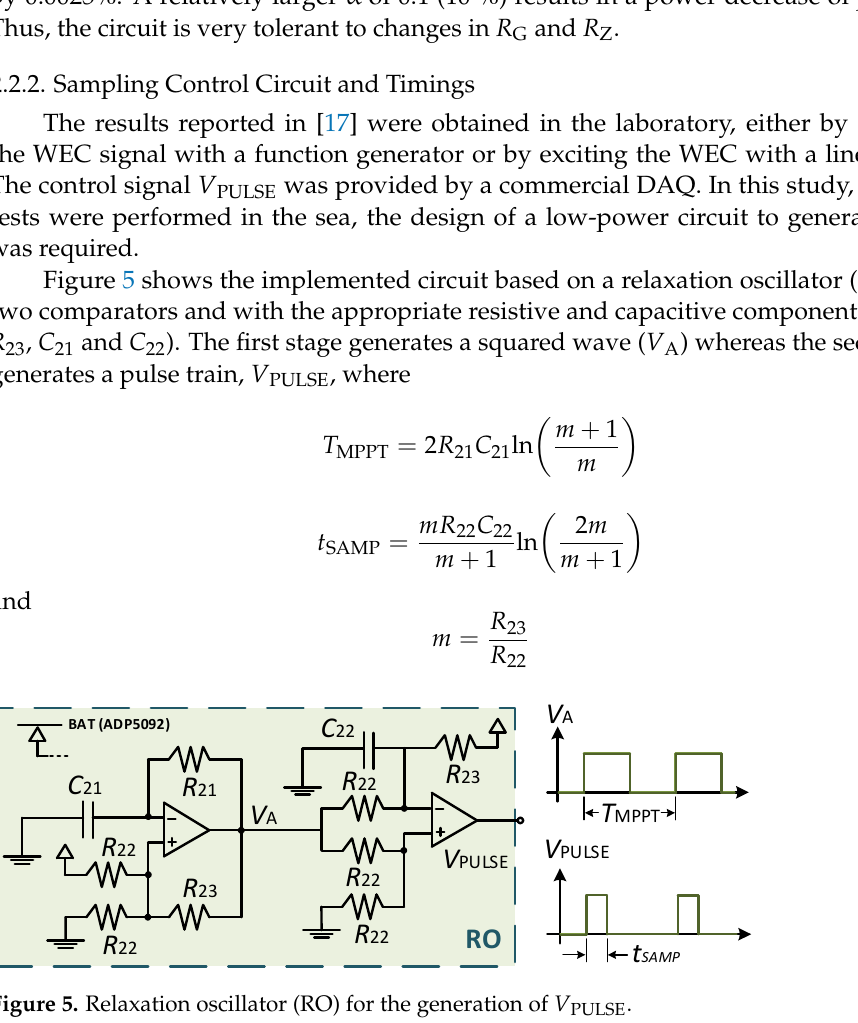
Table 1. Component list for the relaxation oscillator.